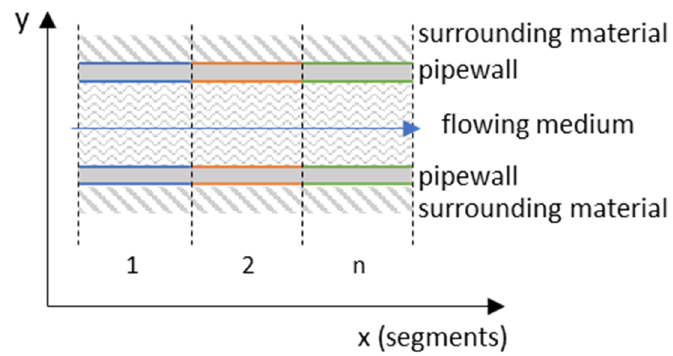
Figure 7. Scheme cut of pipe model with pipe length in x, and material layers in y direction.